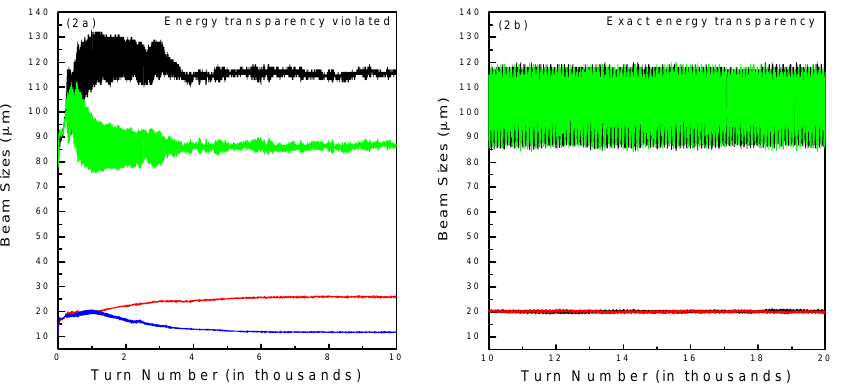
FIG. 2. (Color) Plots of beam size vs turn number for (a) energy (cid:1) (cid:2) 3.1, 9 (cid:3) GeV and (b) energy (cid:1) (cid:2) 3, 9 (cid:3) GeV. All other parameters identical. j 0 (cid:1) 0.124 .